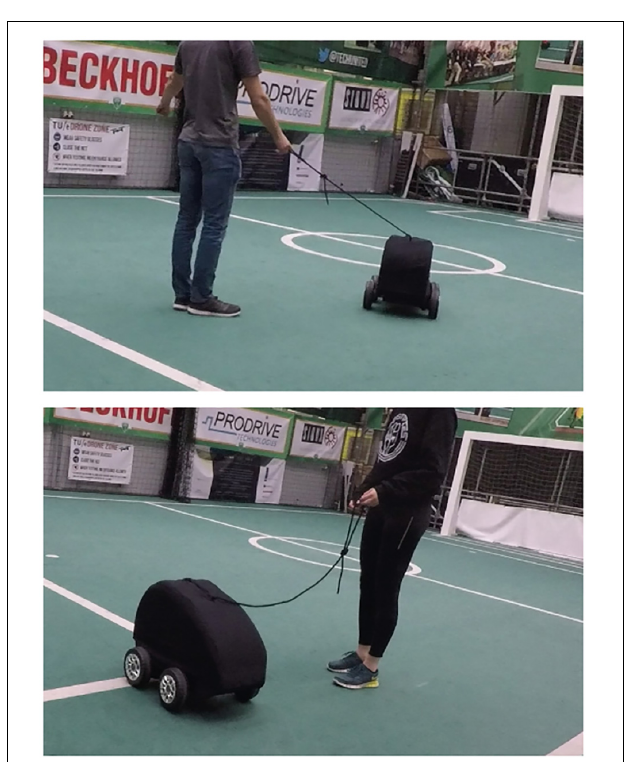
FIGURE 2 | Two participants interaction with the robot showing a situation with a stretched leash and thus in a leading role (top) and situation with a loose leash and thus a following role